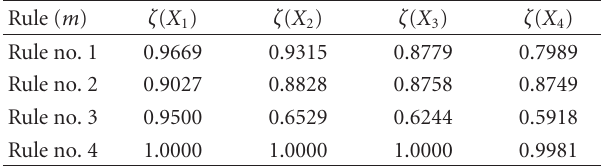
Table 10: Estimated λ -measures.